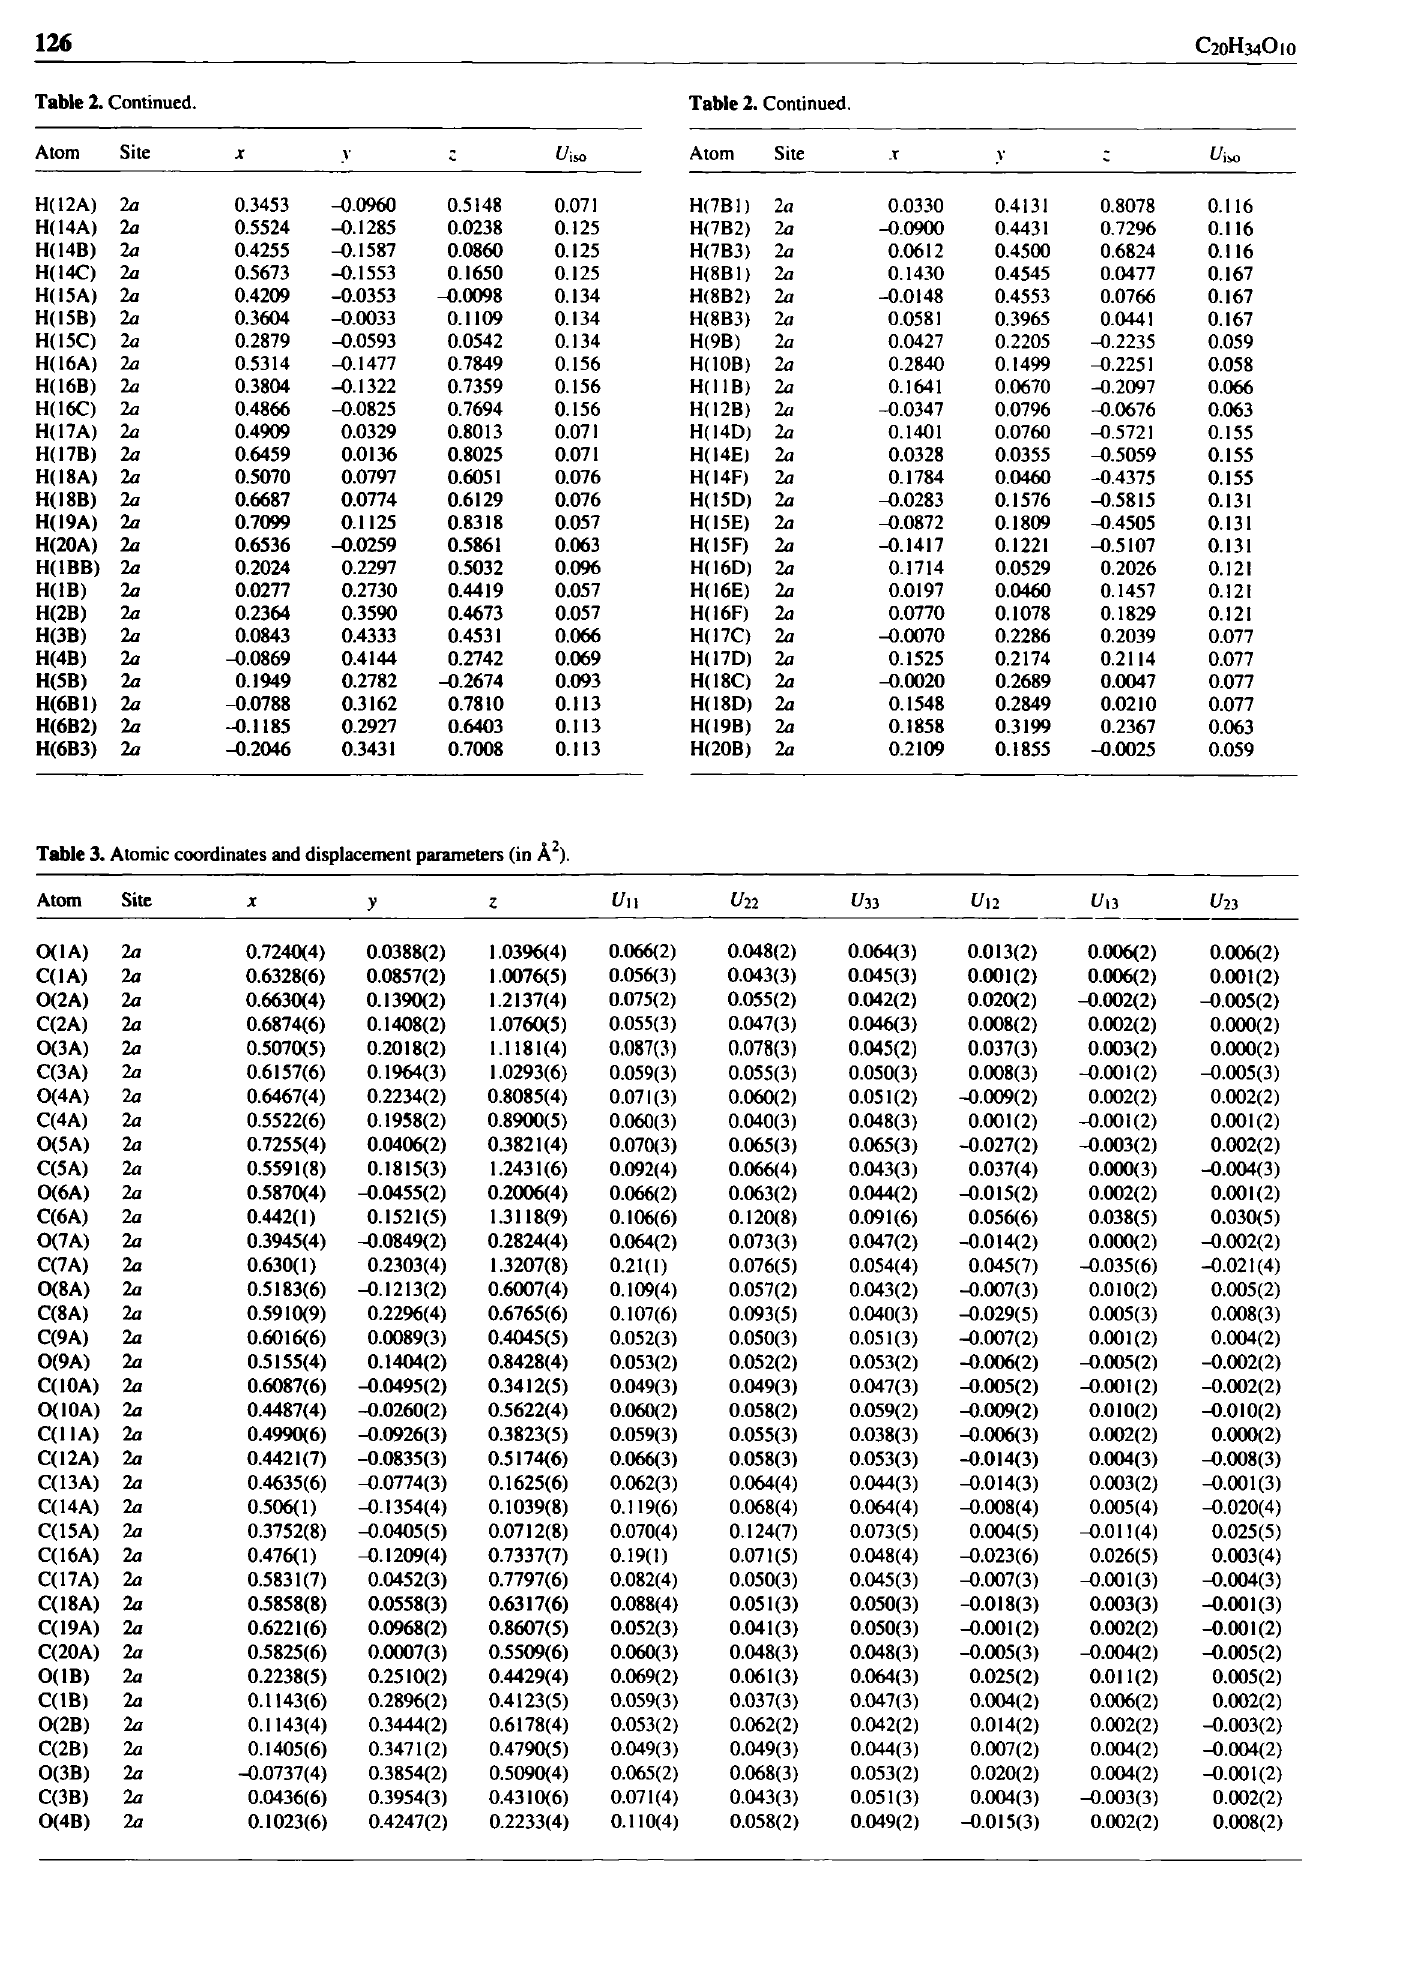
Table 3. Atomic coordinates and displacement parameters (in Â 2